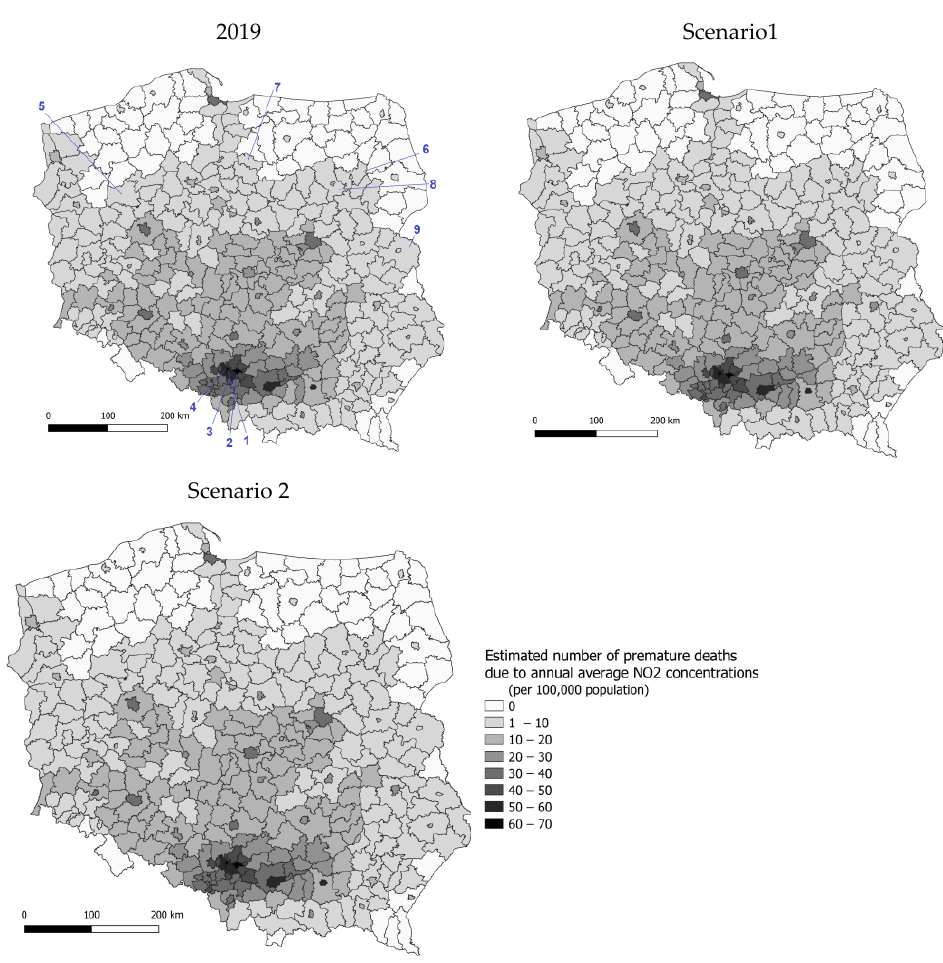
Figure 7. Estimated number of premature deaths due to annual average NO 2 concentrations in 2019, as projected for Scenario 1 and Scenario 2; per 100 000 population; counties averages. Numbers 1–9 refer to the counties presented in Table 3. Table 3. Counties with the highest estimated number of premature deaths due to annual average NO 2 concentrations (per 100,000 population) in 2019 and based on scenarios 1 and 2 forecast. The counties are shown on the map (Figure 7) numbered 1 to